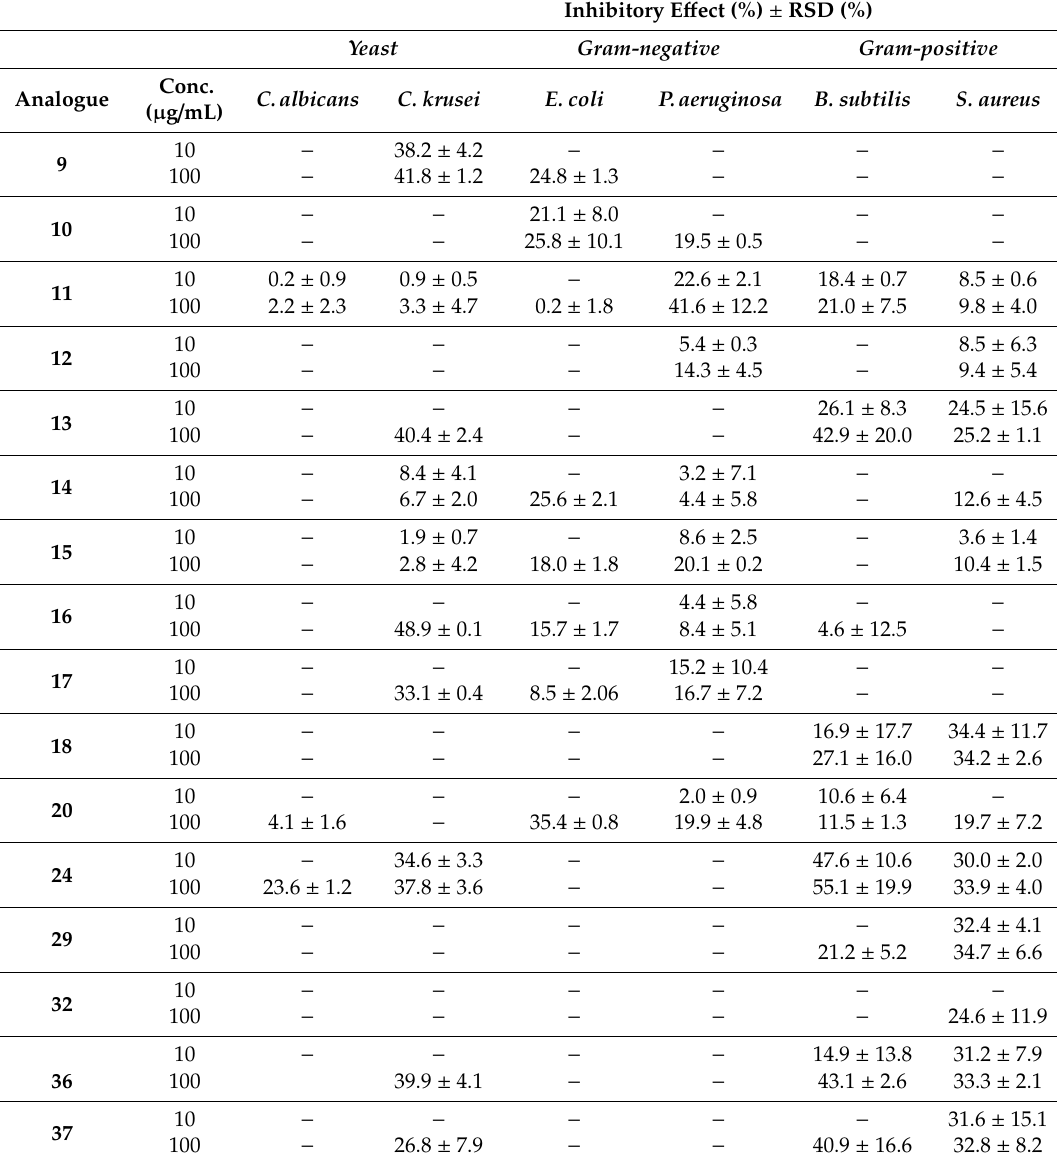
Table 2. Antimicrobial activities of the synthesized